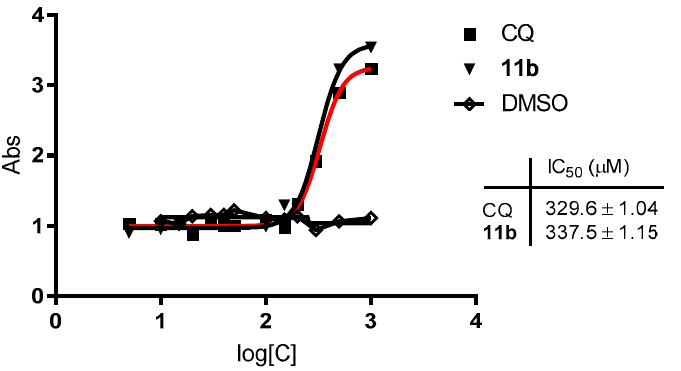
Figure 3. Hemozoin inhibition assay results of compound 11b and CQ from the β -hematin binding assay. The margin of error is estimated in terms of the standard error (±SE).